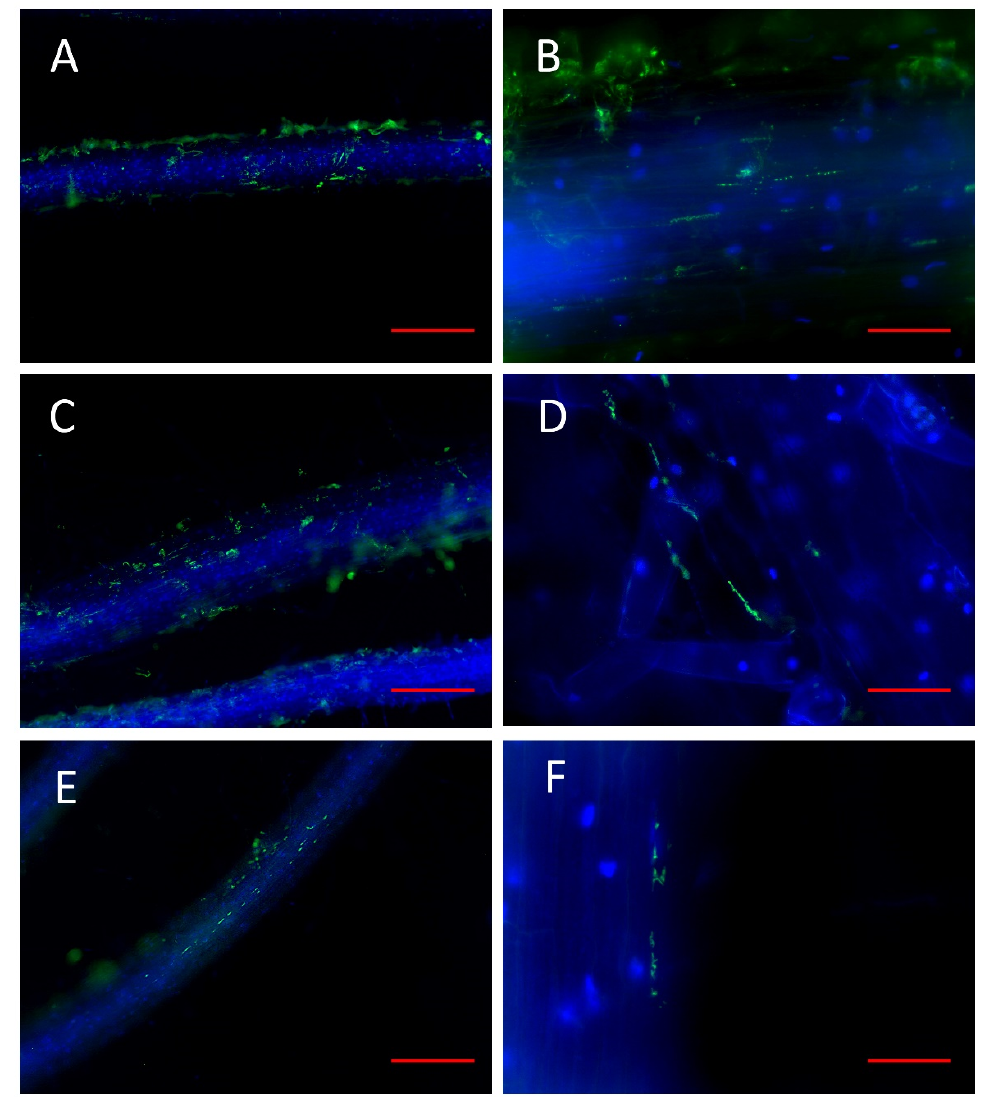
Figure 7. Fluorescence optical micrographs of roots of the blueberry seedlings colonized by Bacillus altitudeinis VMFR45 (( A )-bar = 500 µm, ( B )-bar = 75 µm), Paenibacillus sp. VMFR46 (( C )-bar = 500 µm, ( D )-bar = 75 µm) and Paenibacillus amylolyticus VMSES74 (( E )-bar = 500 µm, ( F )-bar = 75 µm). In green are the immunolocated cells of the studied strains and in blue are root cells stained with calcofluor white.